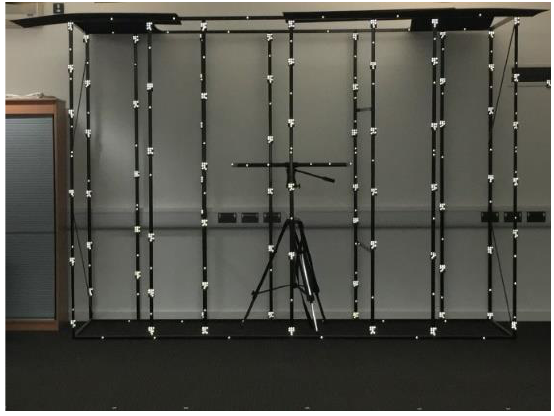
Figure 2: Camera calibration